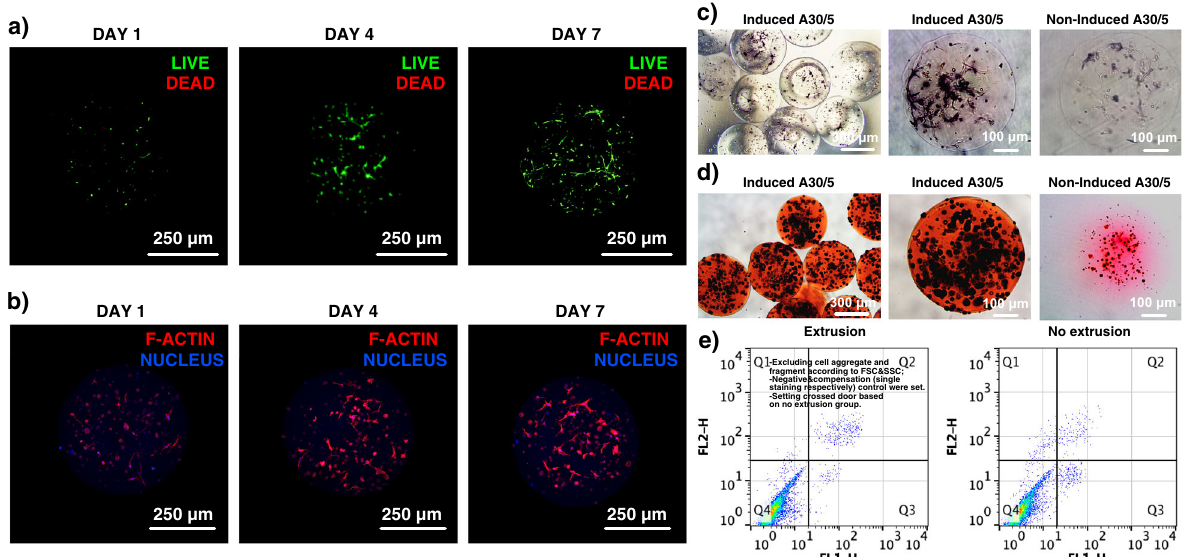
Fig. 6 Culturing and osteogenic induction of BMSCs-laden A component. a Viability of the BMSCs encapsulated in GelMA microgels. b Actin morphology of the BMSCs encapsulated in GelMA microgels. c ALP testing of the osteogenically inducted BMSCs-laden A component. d ARS testing of the osteogenically inducted BMSCs-laden A component. e Apoptosis testing with Annexin V-FITC/PI by fl ow cytometry. For a – d , each experiment was repeated independently with similar results for 3